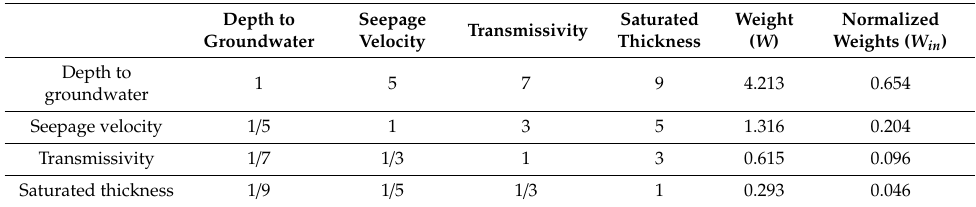
Table 4. Pairwise matrix.